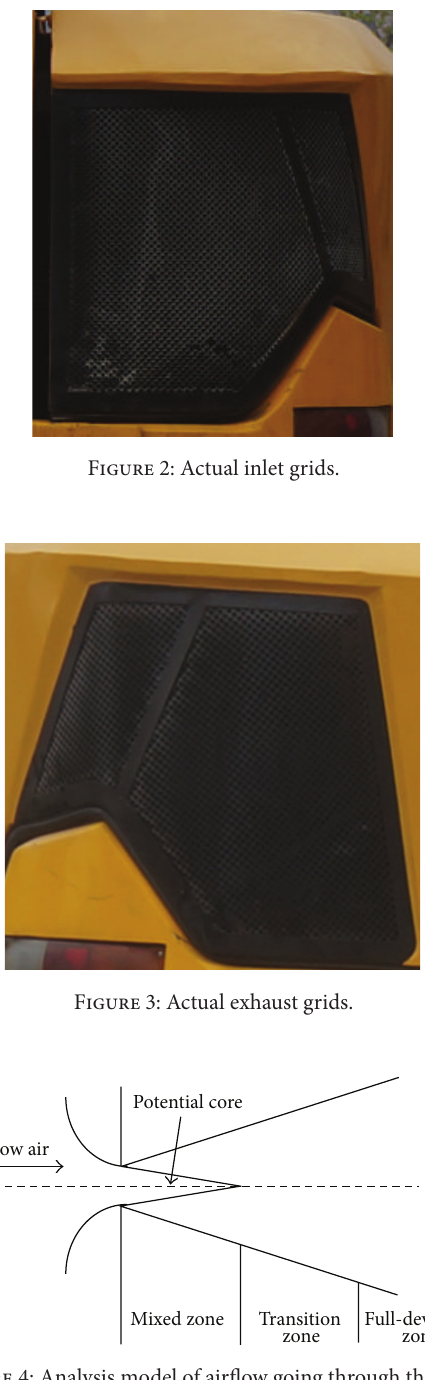
Figure 4: Analysis model of airflow going through the